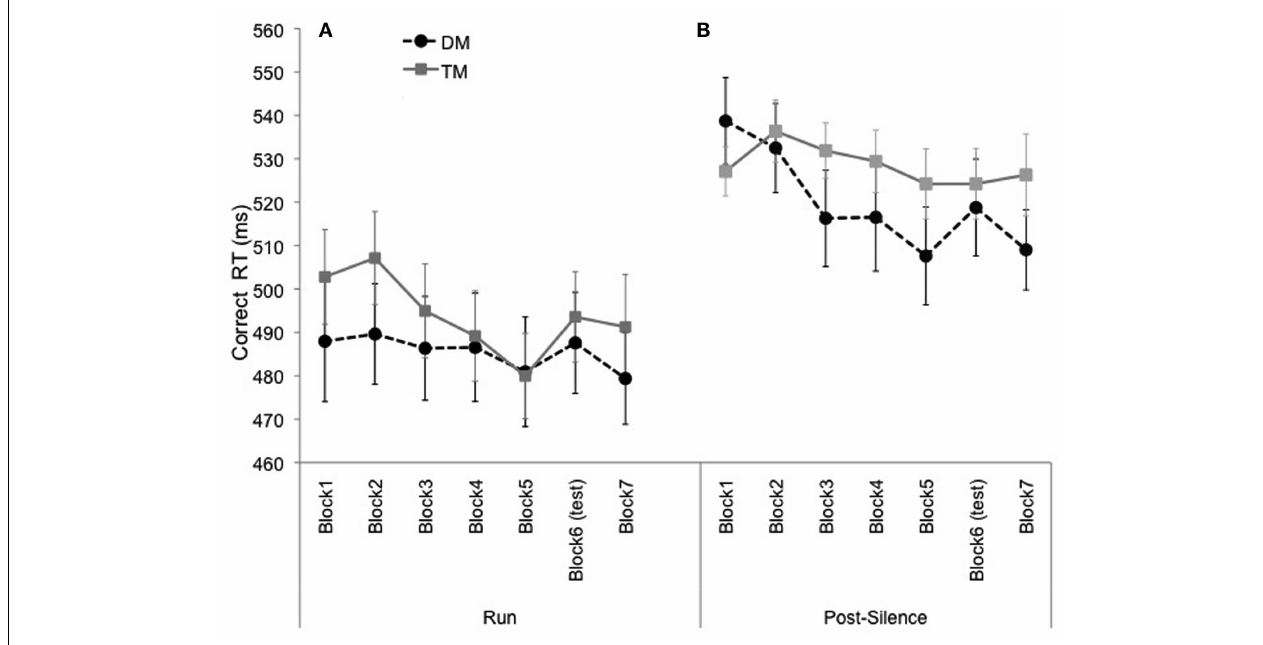
FIGURE 3 | Mean correct RT for Experiment 1 presented as a function of block separated by event-type (run vs. post-silence). (A) Are the run events and (B) are the post-silence events. Error bars represent the standard error of the mean.